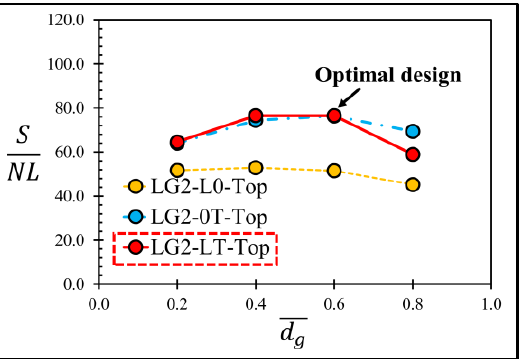
(cid:16) (cid:17) ) with dimensionless groove ) with dimensionless groove S with dimensionless groove 𝑁𝐿 𝑁𝐿 NL